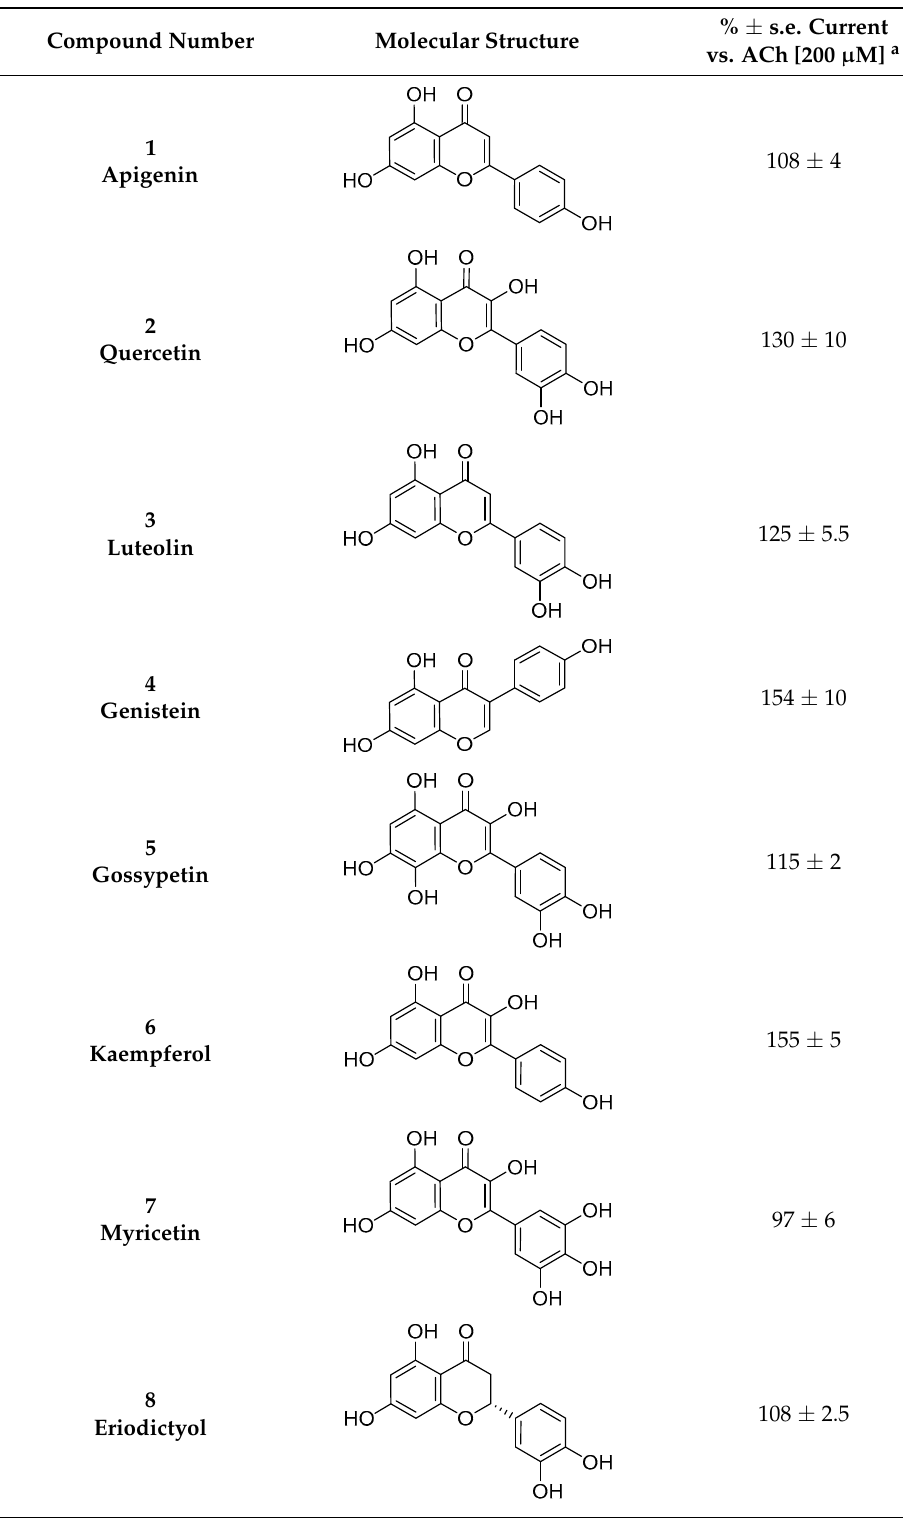
Table 1. Structure of commercial naturally occurring compounds 1 to 14 and their potentiation percentage values of α 7 nAChR currents.